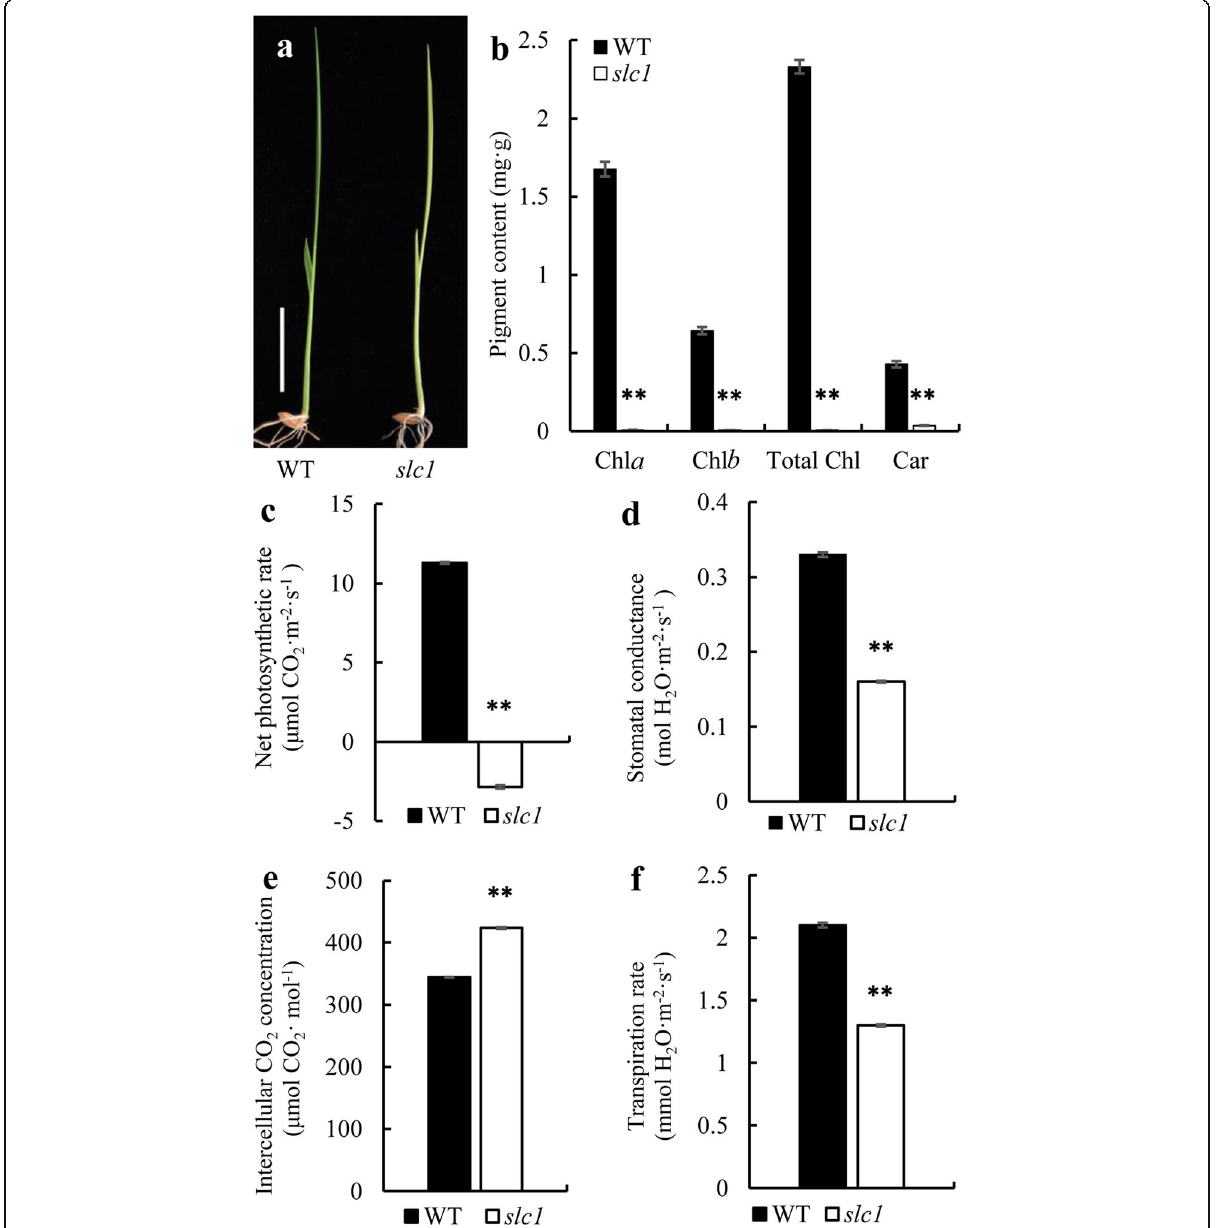
Fig. 1 Phenotypic characteristics of the slc1 mutant and measurement of leaf photosynthetic parameters in the wild type (WT) and slc1 plants at the seedling stage. a Phenotypes of the wild type and slc1 plants at the second-leaf stage. Scale bar, 2 cm. b Leaf photosynthetic pigment contents of the WT and slc1 plants at the third-leaf stage. Chl, chlorophyll; Car, carotenoid. c The net photosynthetic rate. d The stomatal conductance. e The intercellular CO 2 concentration. f The transpiration rate. Three biological replicates were performed. Error bars are SDs. The asterisks indicate statistical significance between the wild type and slc1 mutant, as determined by Student ’ s t-test (** P <